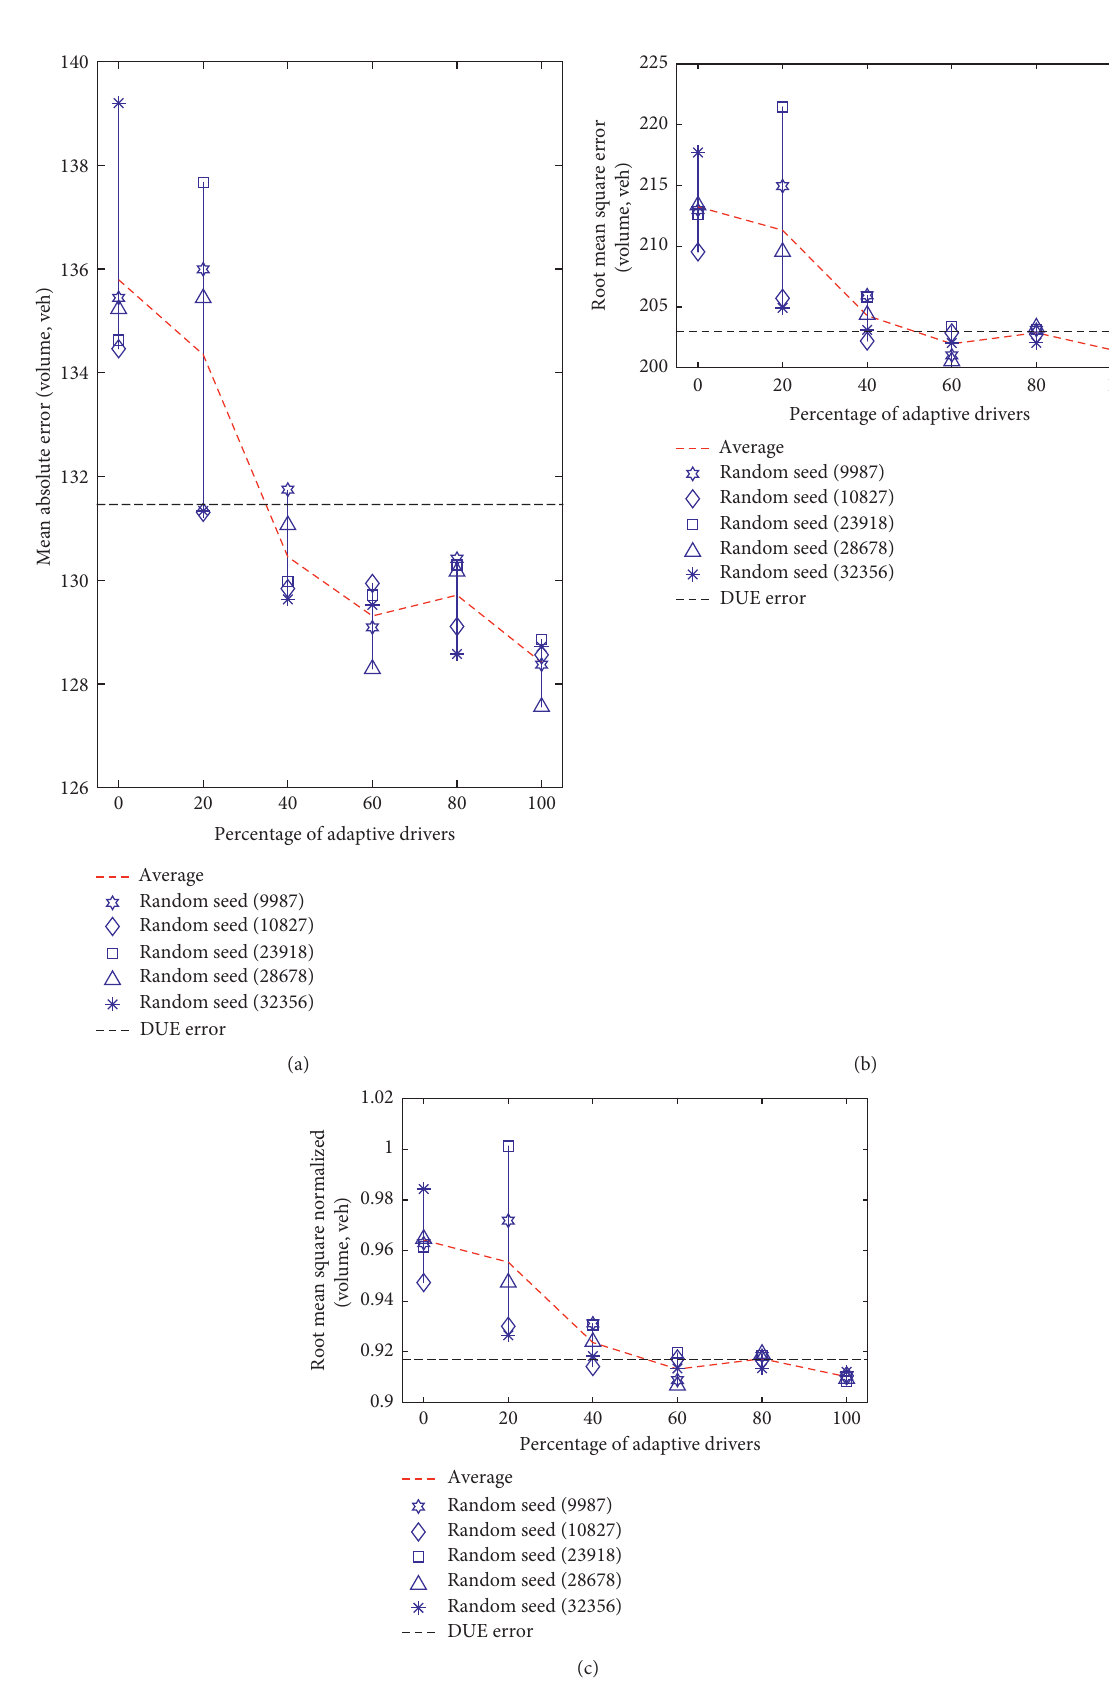
Figure 8: (a) MAE, (b) RMSE, and (c) RMSN for individual link traffic counts from the DUE and SRC with different percentage of adaptive drivers and five replications with different random seeds for each adaptiveness level against observed link volume data. X -axis shows the percentage of adaptive drivers in the network for the SRC and y -axis represents the error as volume (vehicles). DUE error remains constant and is shown as the straight dashed line as no adaptive driving is considered in